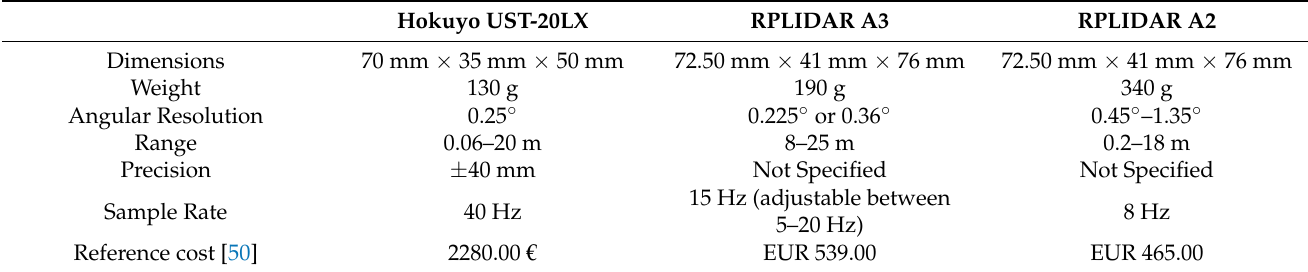
Table 3. Laser Range Scanning Comparison